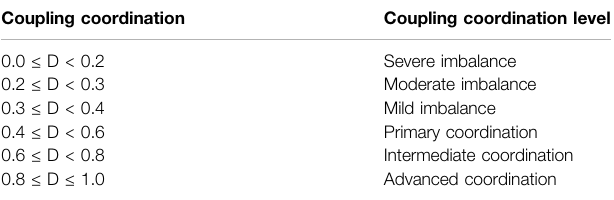
TABLE 2 | Coupling coordination degree grade standard. Coupling coordination Coupling coordination